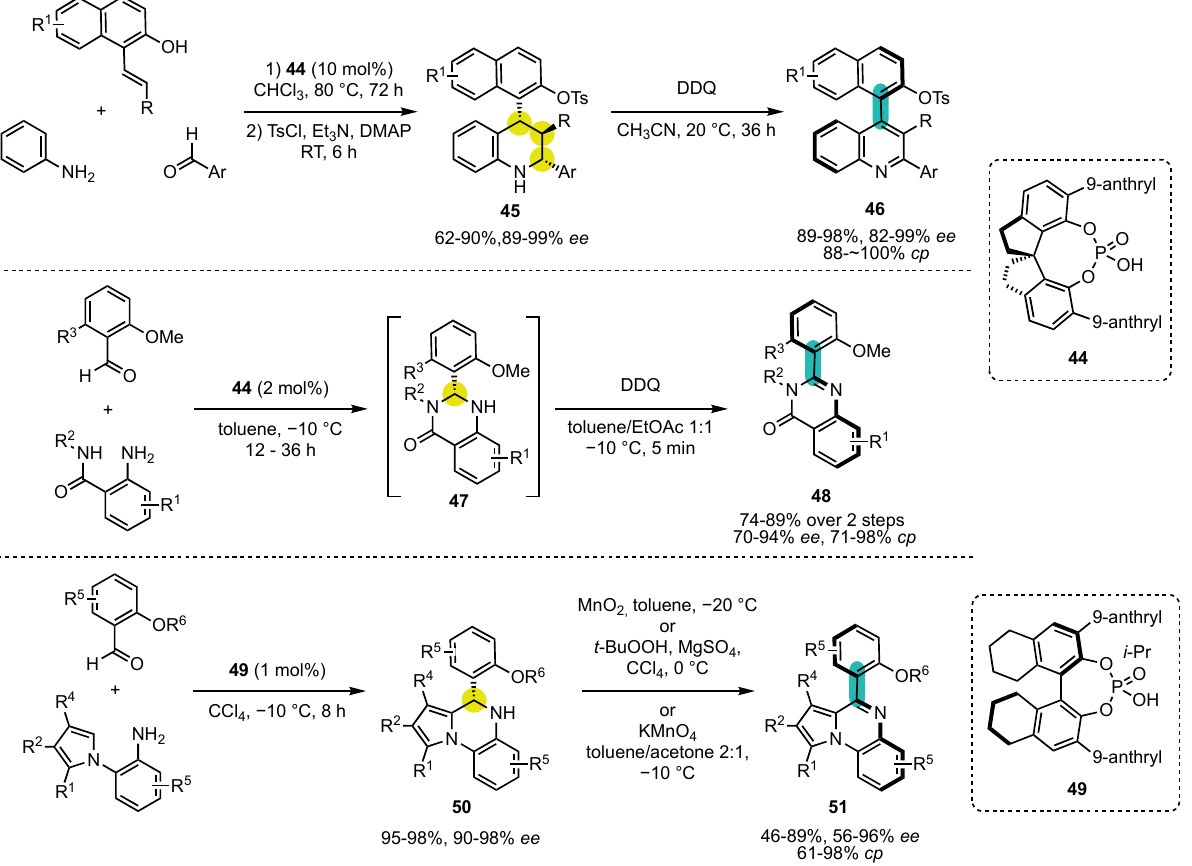
Scheme 13. Atroposelective synthesis of 4 ‐ naphthylquinolines, quinazolinones, and